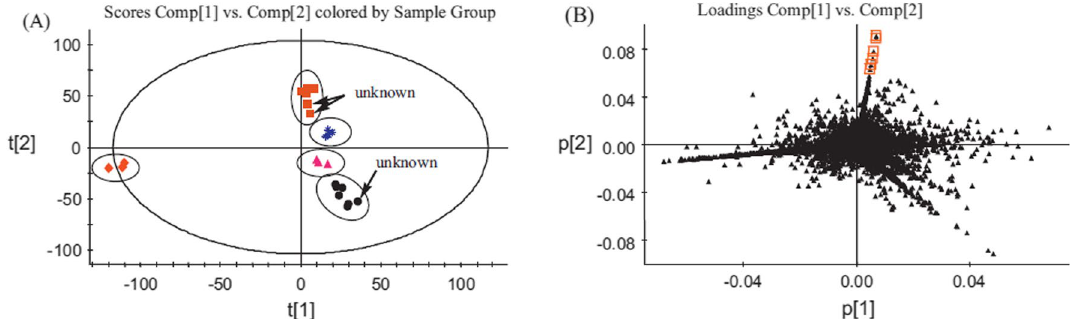
Fig. 6 PCA scoring a and loading plots b for tortoise shell glue ( ), deer-horn glue ( ), porcine gelatin ( ), bovine gelatin ( ), and donkey gelatin ( ). (Cheng et al. 2012) Copyright (2012) with permission from